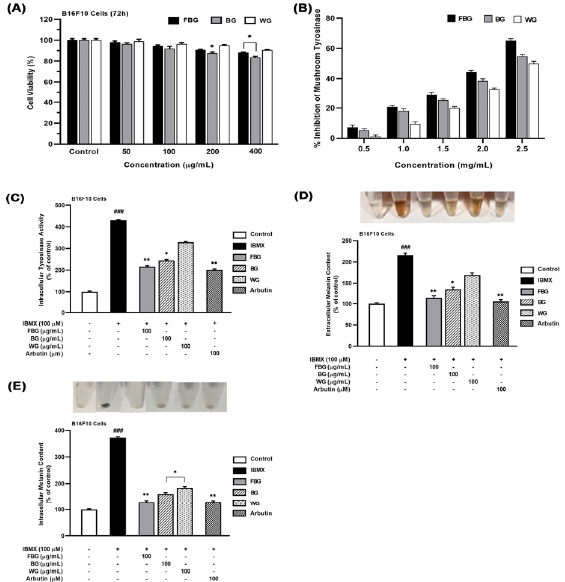
Figure 1. Anti-melanogenic effects of FBG, BG, and WG in B16F10 cells. ( A ) Cytotoxicity effect of FBG, BG, and WG in B16F10 cells for 72 h. The cells were treated with each sample at the indicated concentrations (50, 100, 200, and 400 µ g/mL) for 72 h. The cytotoxicity effect was then determined with MTT assays. ( B ) Inhibition of mushroom tyrosinase was determined in response to the indicated concentration of FBG, BG, and WG (0.5–2.5 mg/mL). ( C ) Intracellular tyrosinase activity in IBMX-stimulated B16F10 cells was measured in response to the concentration of 100 μ g/mL of FBG, BG, WG, or arbutin (100 μ M) for 72 h. The IBMX-stimulated B16F10 cells were treated with a concentration of 100 µ g/mL of FBG, BG, or WG, or arbutin (100 µ M) for 72 h, and ( D ) the extracellular and ( E ) the intracellular melanin contents were measured at 475 and 405 nm, respectively. The graph shows mean ± SD values of three replicates. ### p < 0.001, as compared with the control group; * p < 0.05, ** p < 0.01, as compared with the IBM- induced group.